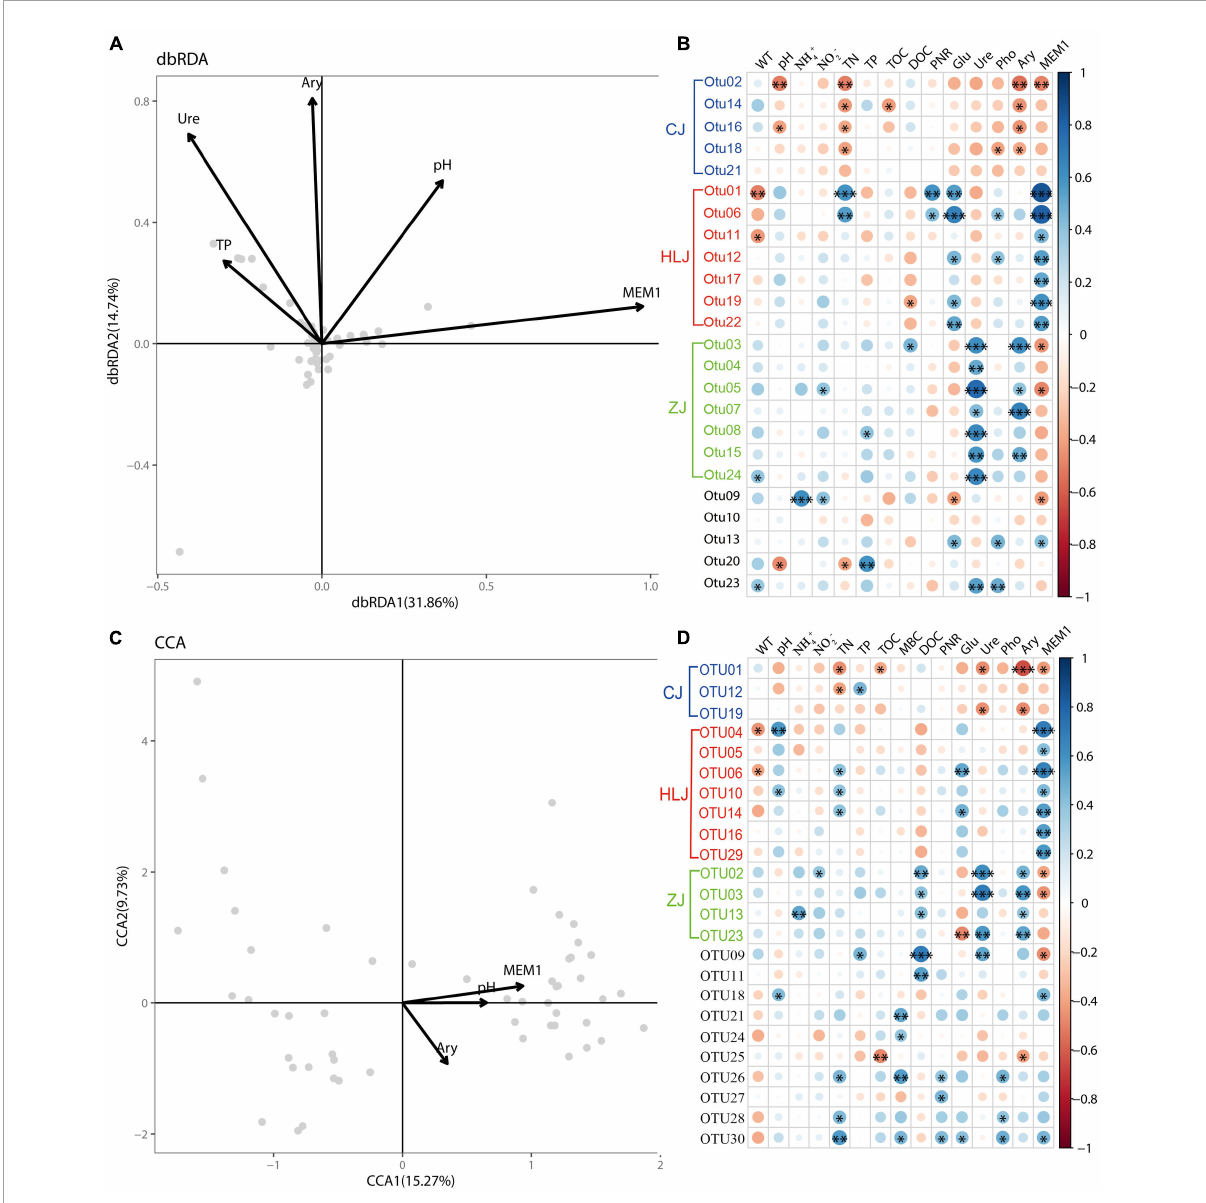
FIGURE5 Relationship between sediment properties and the spatial factor MEM1 and ammonia-oxidizing archaea (AOA) and ammonia-oxidizing bacteria (AOB) communities: distance-based redundancy analysis (db-RDA) (A) and heatmap (B) for AOA communities; canonical correlation analysis (CCA) (C) and heatmap (D) for AOB communities. Only values with a correlation efficient > 0.6 or p value < 0.05 are presented. The spatial factor MEM1 was generated by distance-based Moran’s eigenvector maps. The differentially abundant OTUs between different areas are indicated in different colors: CJ–blue, HLJ–red, and ZJ–green. The asterisks indicate significant correlations, with ∗ P -value < 0.05, ∗∗ P -value < 0.01, ∗∗∗ P -value <